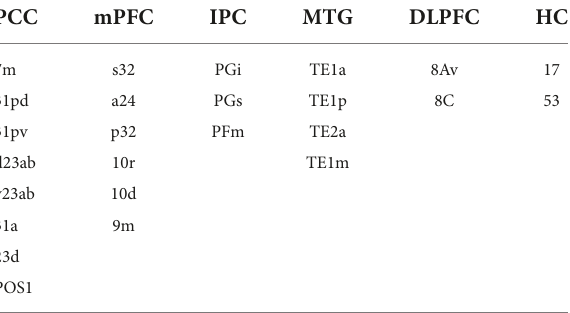
TABLE 1 List of parcels from the HCP_MMP1.0 atlas and the subcortical ROIs from FSL’s FIRST segmentation combined to form the six ROIs for the default mode network.